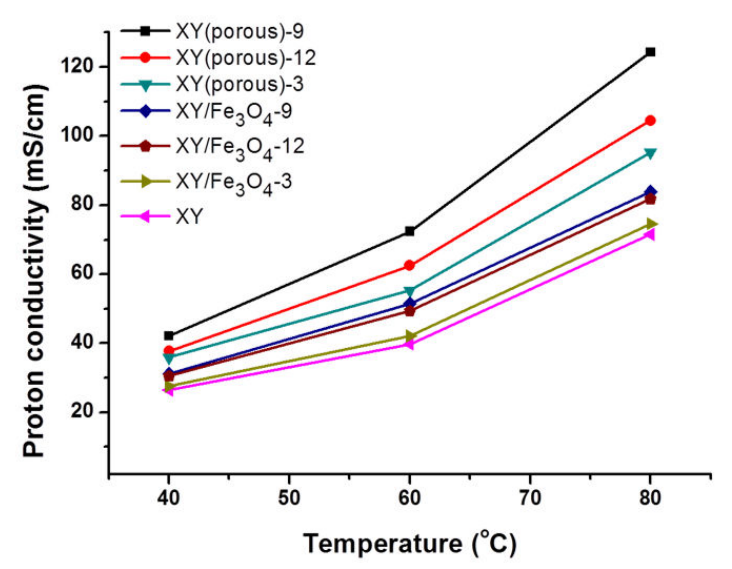
Figure 11. Proton conductivity plots of the bare XY, composite, and porous membranes.